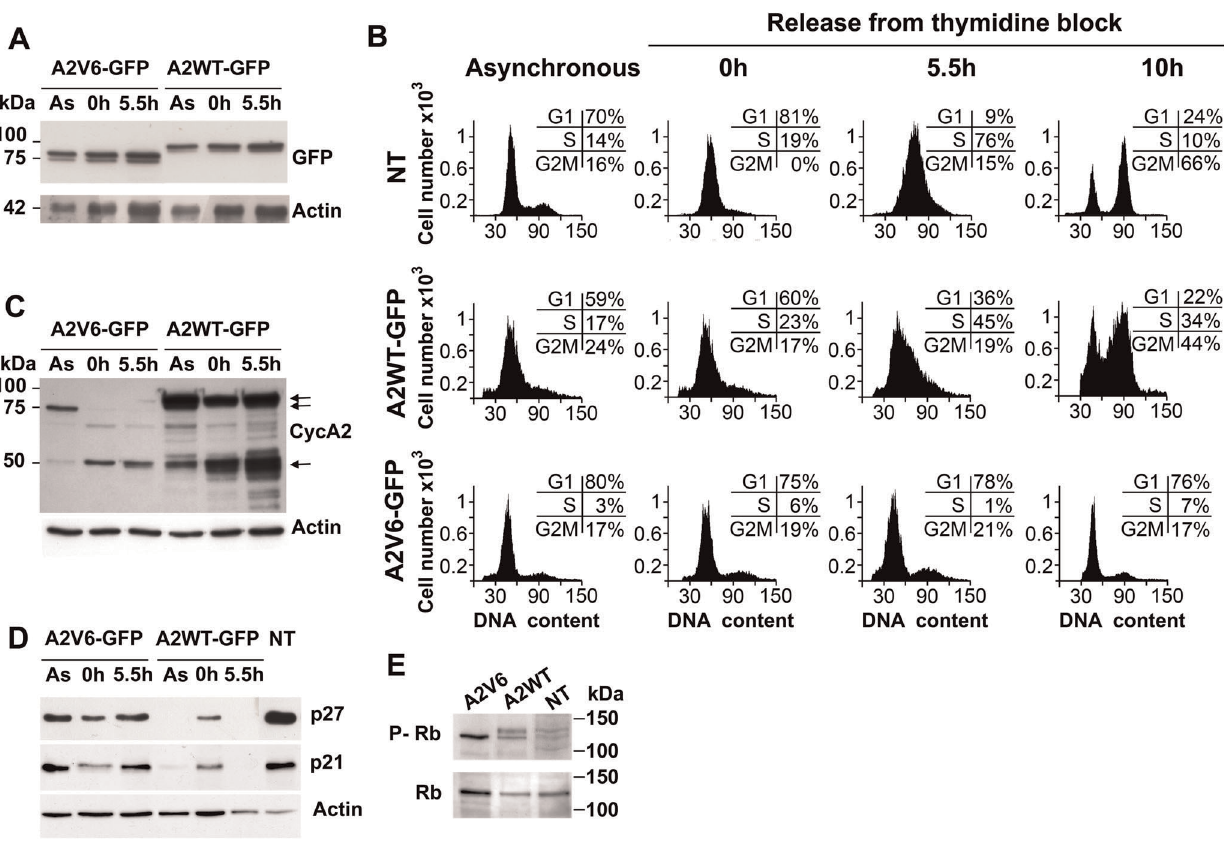
Figure 3. Overexpression of A2V6-GFP induces a G1/S arrest. HeLa cells were transfected with wild-type cyclin A2-GFP (A2WT-GFP) or Intron 6-retaining cyclin A2-GFP (A2V6-GFP) vectors. The analyses were performed in asynchronous cells (As), in thymidine-synchronized cells (0 h) and at the indicated times (5.5 h, 10 h) after thymidine removal. ( A ) Anti-GFP immunoblot. The molecular mass of the GFP fusion proteins is 75–80 kDa. Actin: normalization using b -actin. ( B ) Cell cycle analysis using flow cytometry. Inset: percentage of cells in the different phases of the cell cycle. NT: non-transfected cells. Cells expressing A2V6-GFP were arrested in G1/S phase while cells expressing endogenous cyclin A2 or A2WT-GFP were progressing through the cell cycle. ( C ) Anti-cyclin A2 immunoblot in lysates from cells expressing A2V6- and A2WT-GFP showing the expression of endogenous cyclin A2 (single arrow) and the GFP fusion proteins (double arrow). Actin: normalization using b -actin. ( D ) Immunoblots for the CDK inhibitors p21 and p27 in lysates from cells expressing A2V6- and A2WT-GFP demonstrating their accumulation in A2V6-GFP expressing cells